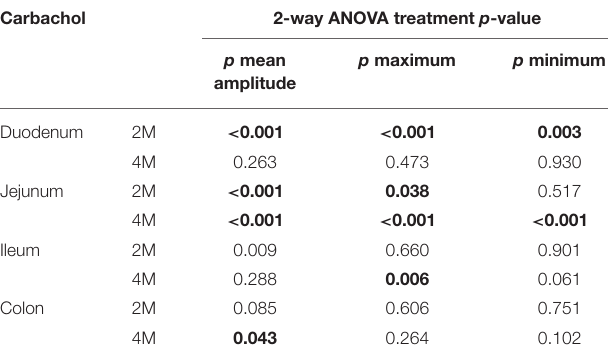
TABLE 1 | Statistical results comparing the reaction to carbachol between vehicle and rotenone-exposed mice. Carbachol 2-way ANOVA treatment p